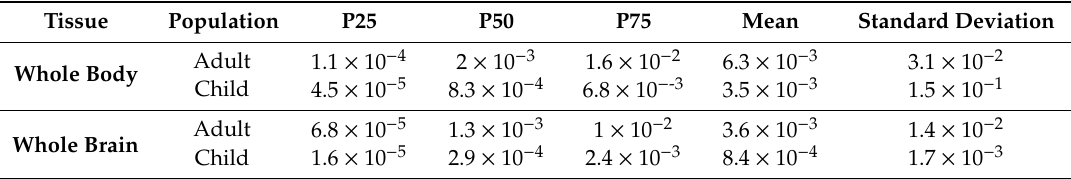
Table 2. Descriptive statistics of the cumulative distribution functions of mobile phone use exposure profiles (SAR in mW/kg).